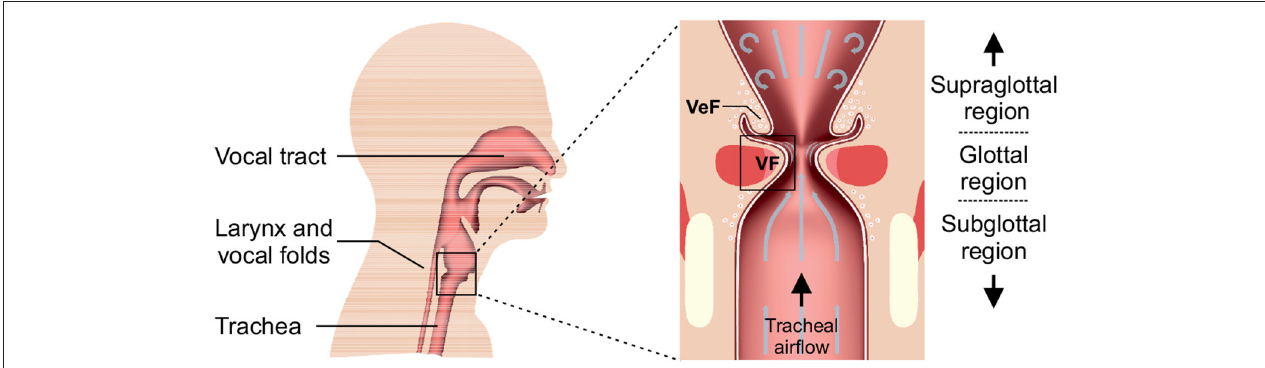
FIGURE 1 | 2D view of a human head (left) with an enlargement of the larynx (right) and its embedded structures that are important for the phonatory process. The vocal folds (VF) and the above arranged ventricular folds (VeF) are